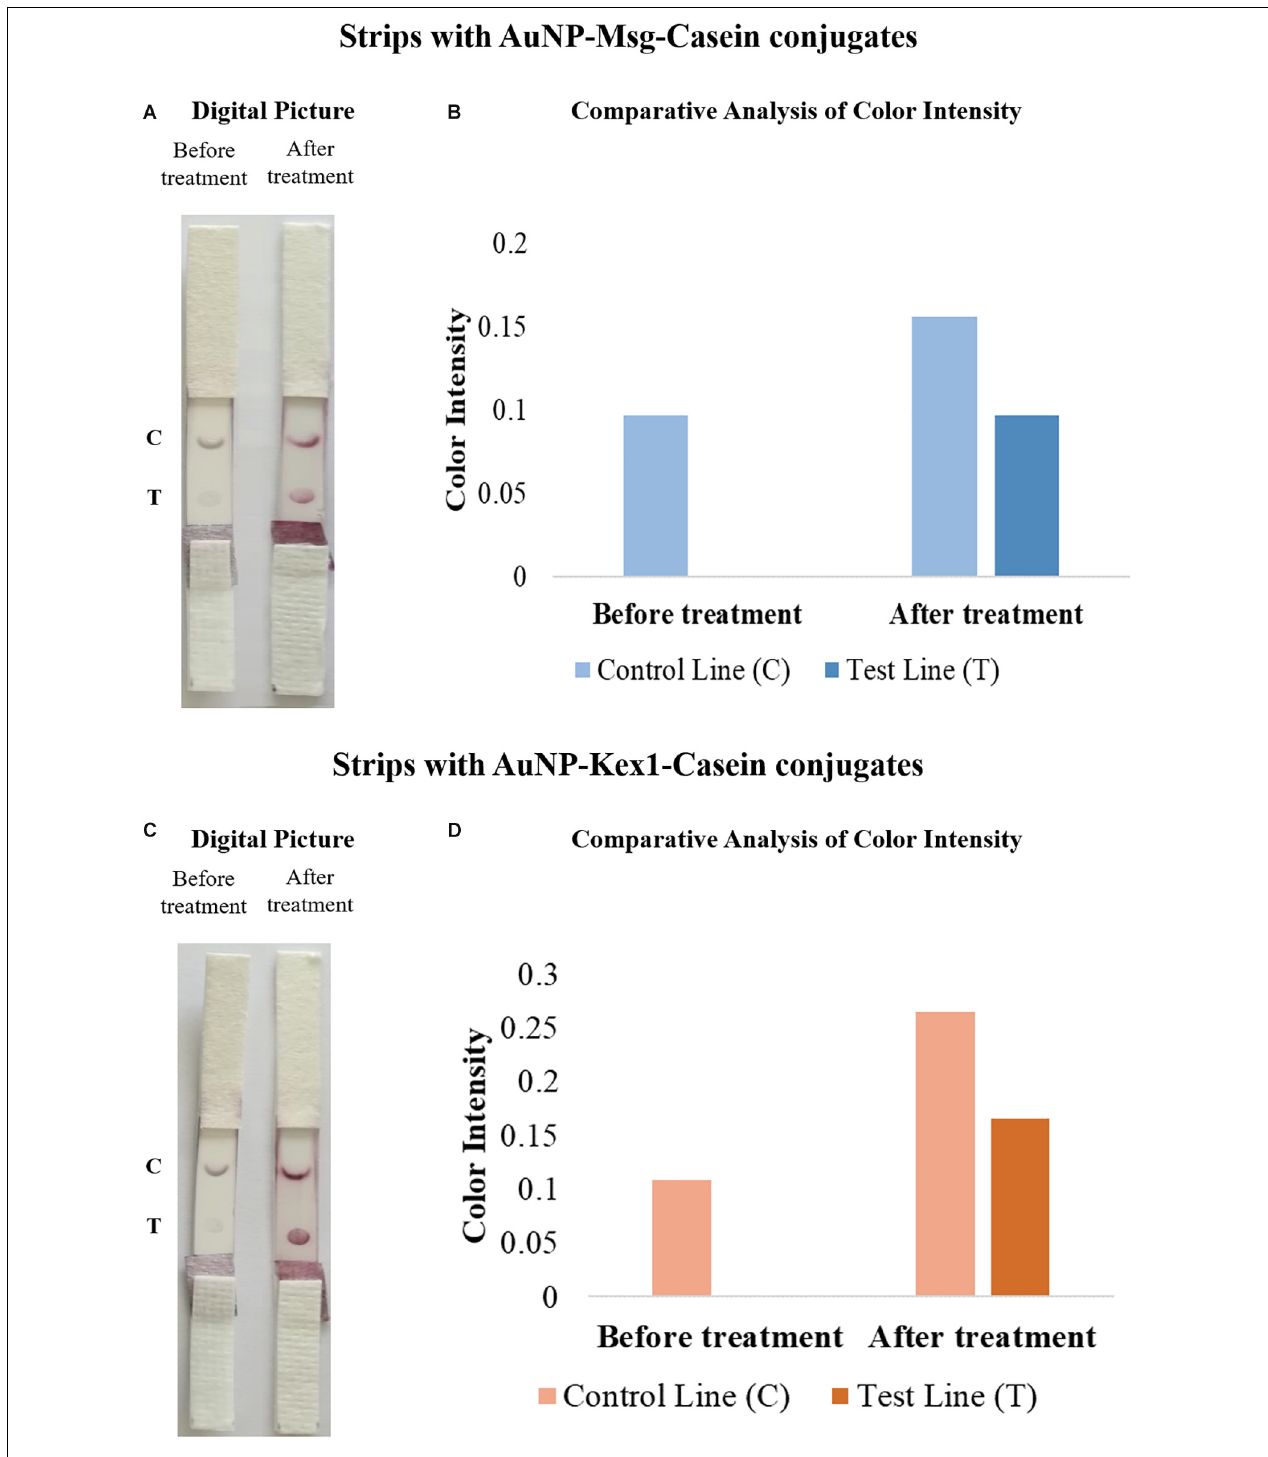
FIGURE 6 | Comparative analysis of the results from LFIA strips containing AuNP-Msg-Casein conjugates (A,B) and AuNP-Kex1-Casein conjugates (C,D) in the presence (after treatment) and absence (before treatment) of conjugate and sample pad pre-treatments. (A,C) Digital pictures of strips before and after conjugate pad treatment with a buffer (5% sucrose, 1% BSA and 0.5% Tween 20) and sample pad treatment with 0.03% anti-human immunoglobulin G. From bottom to top, strips were composed by the sample pad, the conjugate pad, the nitrocellulose membrane with the test (T) and control (C) lines and the absorbent pad. (B,D) Quantification of color intensity of the control and test lines, where the intensity shown in each line corresponds to the maximum height of the Gaussian line fitted by eReuss software.